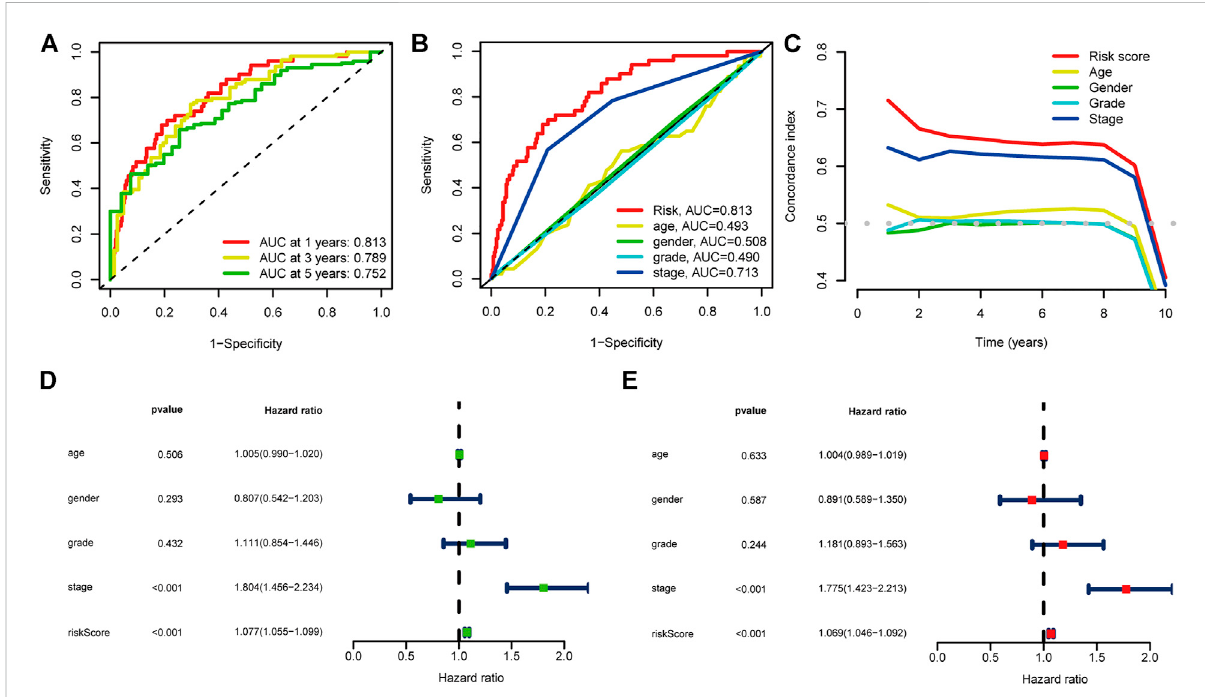
FIGURE 3 Evaluation of the prognostic cuproptosis-associated lncRNAs signature (A) ROC curve and AUCs at 1-year, 3-years and 5-years survival for the predictive signature. (B) The ROC curve of the risk score and clinicopathological variables (C) C index of the risk score and clinicopathological variables. (D) Forest plot for univariate Cox regression analysis. (E) Forest plot for multivariate Cox regression